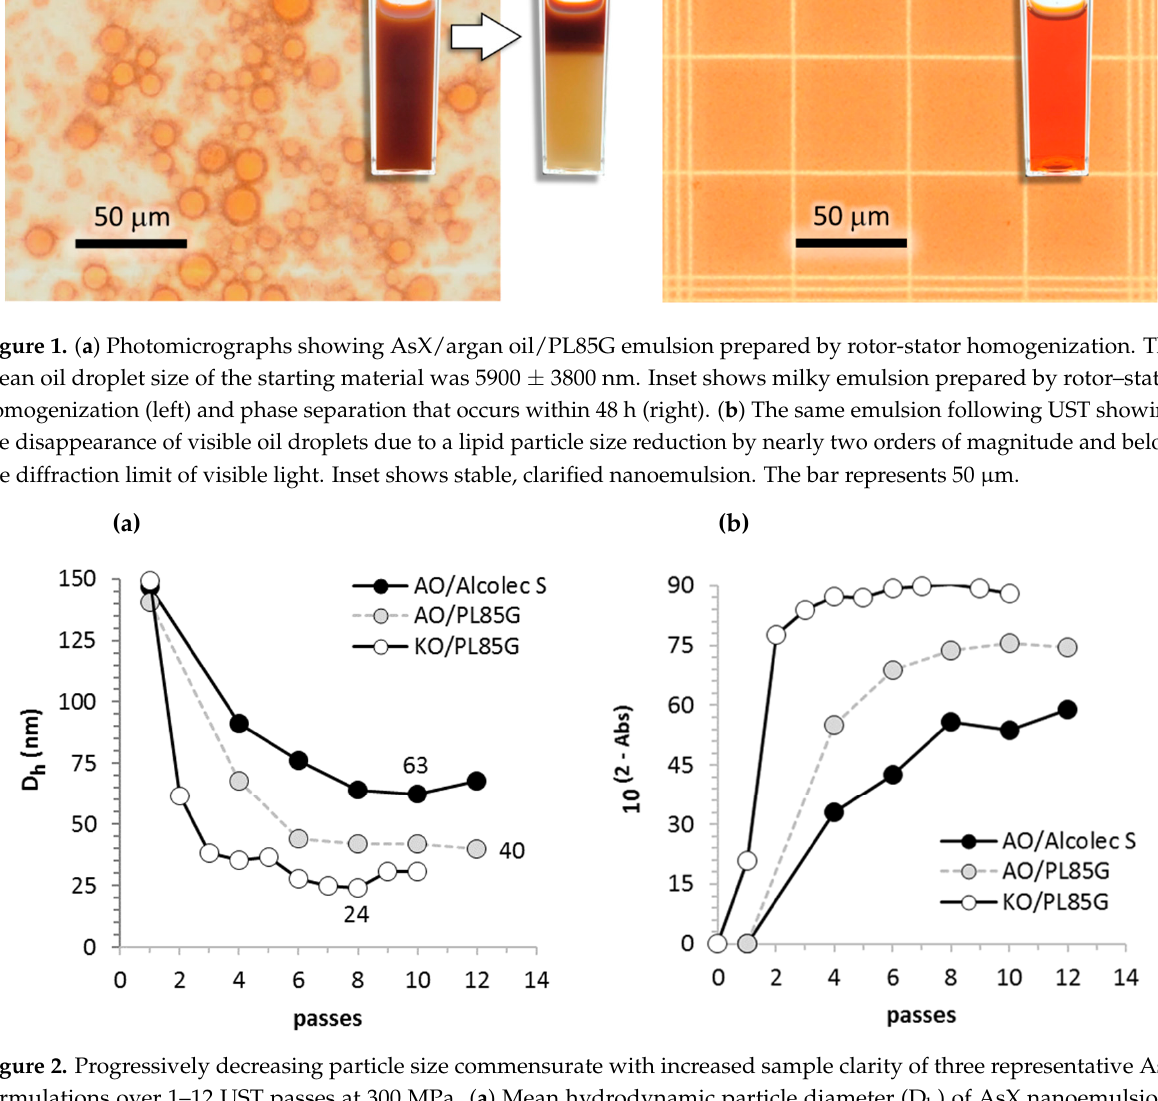
Figure 2. Progressively decreasing particle size commensurate with increased sample clarity of three representative AsX formulations over 1–12 UST passes at 300 MPa. ( a ) Mean hydrodynamic particle diameter (D h ) of AsX nanoemulsions formed in argan oil (AO) or krill oil (KO) formulations. Surfactants were 5% PS20 and either 4% Alcolec S or 4% PL 85G. The KO/PL85G formulation produced the smallest particle size at the fastest rate (38 nm after three UST cycles) and reached a minimum size of 24 nm after eight cycles. ( b ) Sample clarity quantified by absorbance at 595 nm and expressed as transmittance. KO/PL85G nanoemulsions were most clear due to the smallest particle size obtained in the three formulations.